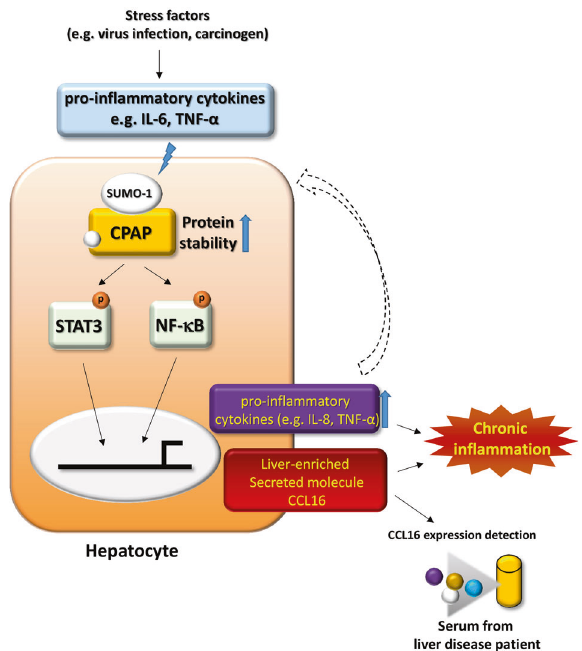
Fig. 8 CPAP promotes and maintains liver in fl ammation by increasing the secretion of in fl ammatory cytokines via STAT3 and NF- κ B. Upon viral infection or hepatic injury, human hepatocytes are under the stimulation of in fl ammatory cytokines, which increases CPAP protein stability through SUMO-1 modi fi ca- tion. SUMO-1-modi fi ed CPAP enhances the expression of in fl amma- tory cytokines, including TNF- α , IL-8, and CCL-16, by promoting the transcriptional activities of STAT3 and NF- κ B. This CPAP-mediated enhancement of cytokine expression contributes to the chronic in fl ammatory microenvironment surrounding